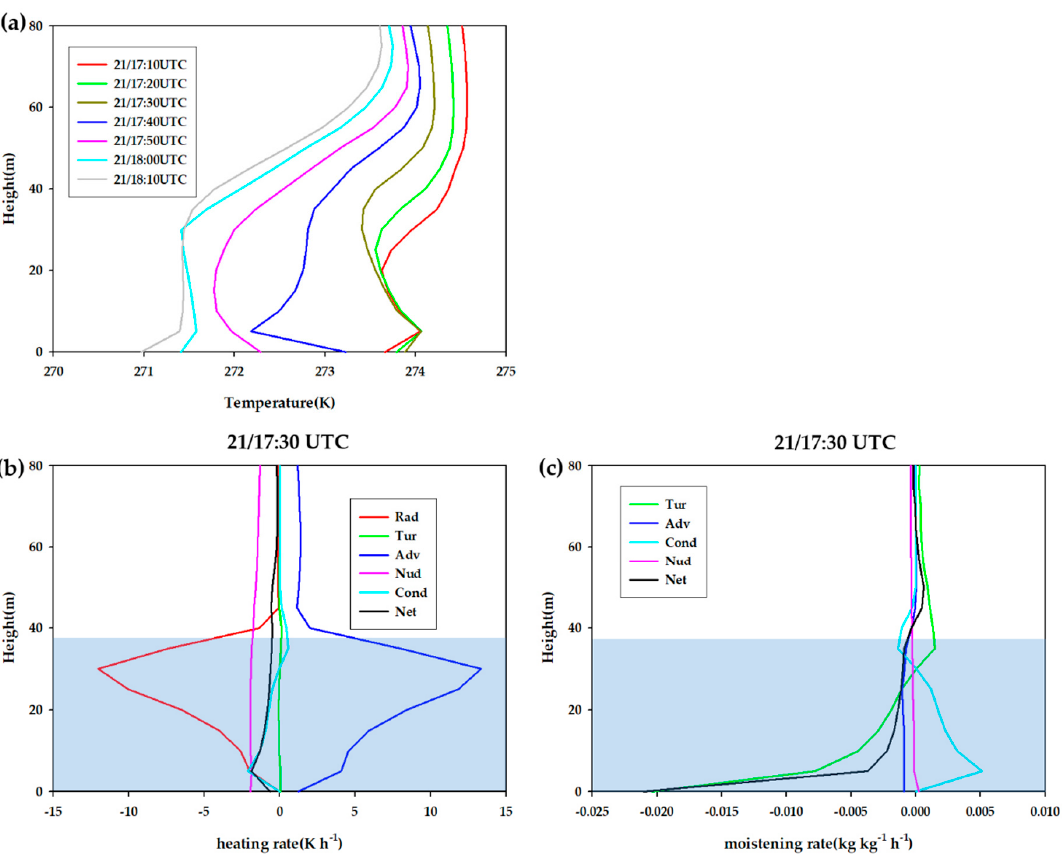
Figure 8. Same as Figure 7 except ( a ) the vertical profiles of temperature at later times and vertical profile of ( b ) heating rates and ( c ) moistening rates at 17:40 UTC. The blue shading indicates the fog layer.